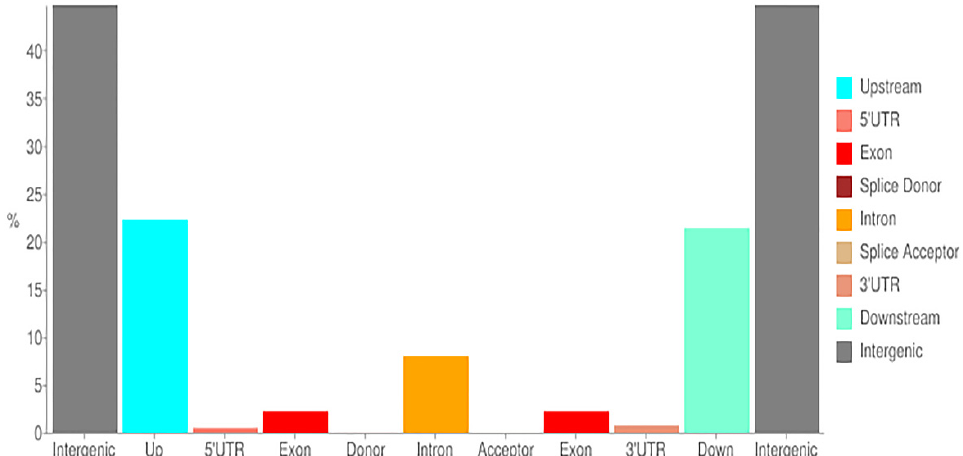
Figure 3. Location of various SNP variations found in newly sequenced areas of parental lines of melon. The x -axis represents the regions of distribution, and y -axis represents the proportion of SNPS in each